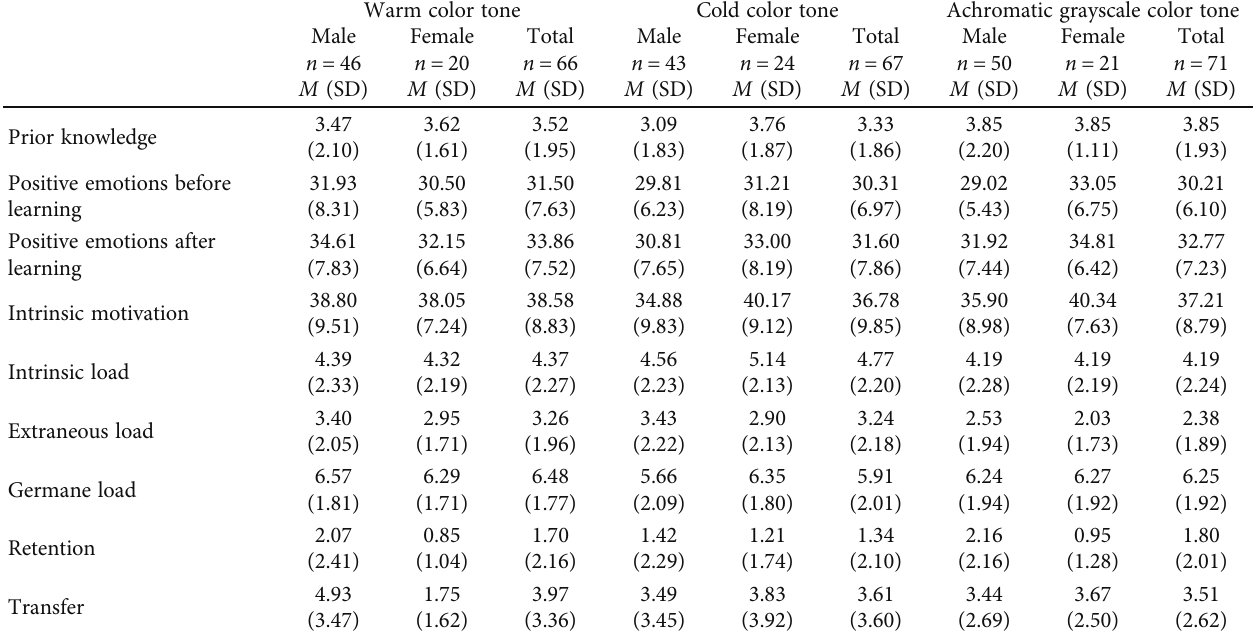
Table 1: Means and standard deviations of the measures for the e-learning color tones and learners ’ gender. Warm color tone Cold color tone Achromatic grayscale color